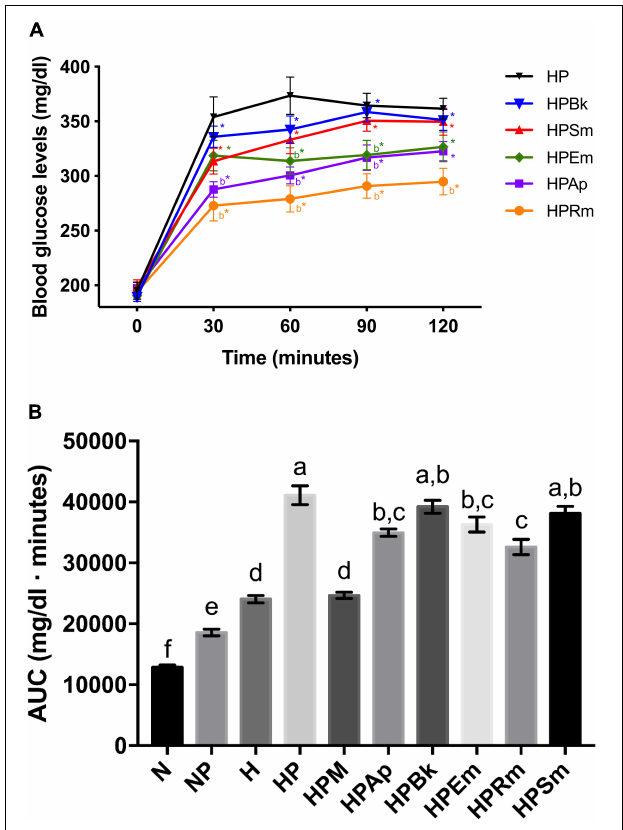
FIGURE 1 | Effect of plant extracts on pyruvate tolerance tests on STZ-NA induced hyperglycemic rats. (A) Comparison of plant extract curves. Letter “b” indicates significant difference versus hyperglycemic + pyruvate group (HP) at p < 0.05; *indicates significant difference with time 0 of the same group at p < 0.05. (B) AUC values. The bars represent the mean ± SEM. Different letters over bars indicate statistically significant differences at p < 0.05 (a > b > c > d > e > f). N, normoglycemic group; NP, normoglycemic + pyruvate group; H, hyperglycemic; HP,